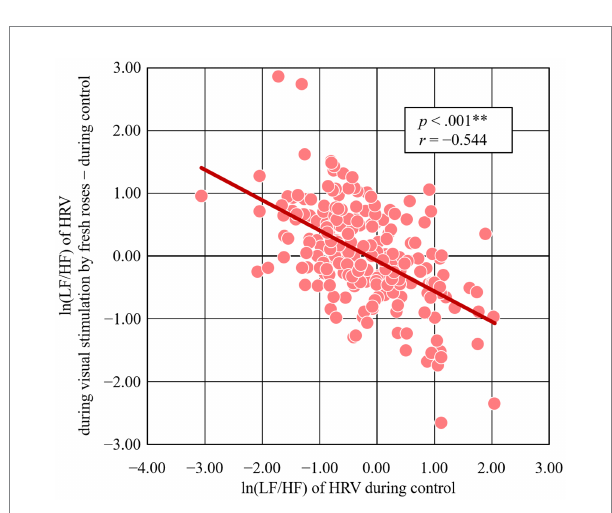
FIGURE 5 Relationship between the initial and change in ln (LF/HF) of HRV induced by visual stimulation with fresh roses. N = 214, ** p < 0.001 by Pearson’s